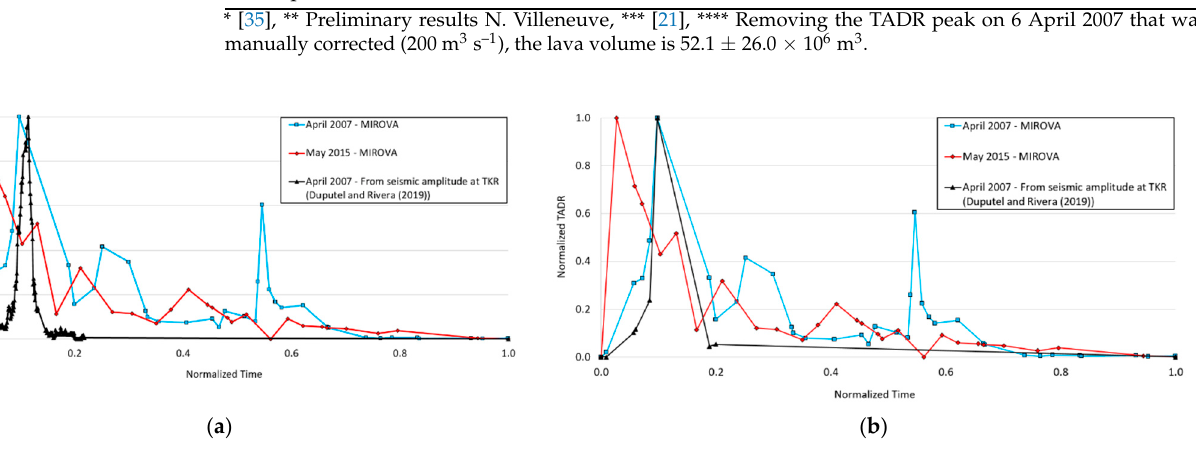
Figure 5. Normalized TADR trend from MIROVA datasets for the April 2007 (in blue) and May 2015 (in red) eruptions. The abscissa axis represents the elapsed time from the first measurement corresponding to the beginning of the eruption, normalized at 1. The black line represents the time-series of seismically-derived TADR from Duputel and Rivera (2019) [34]: ( a ) the complete dataset; ( b ) selected data corresponding to the MIROVA measurements.